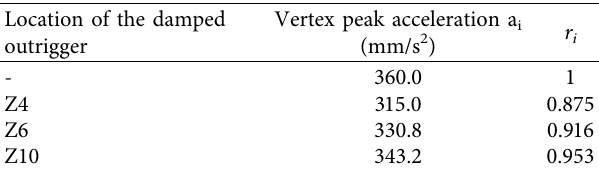
Table 12: Sensitive vector (scalar) of each damped outrigger location.